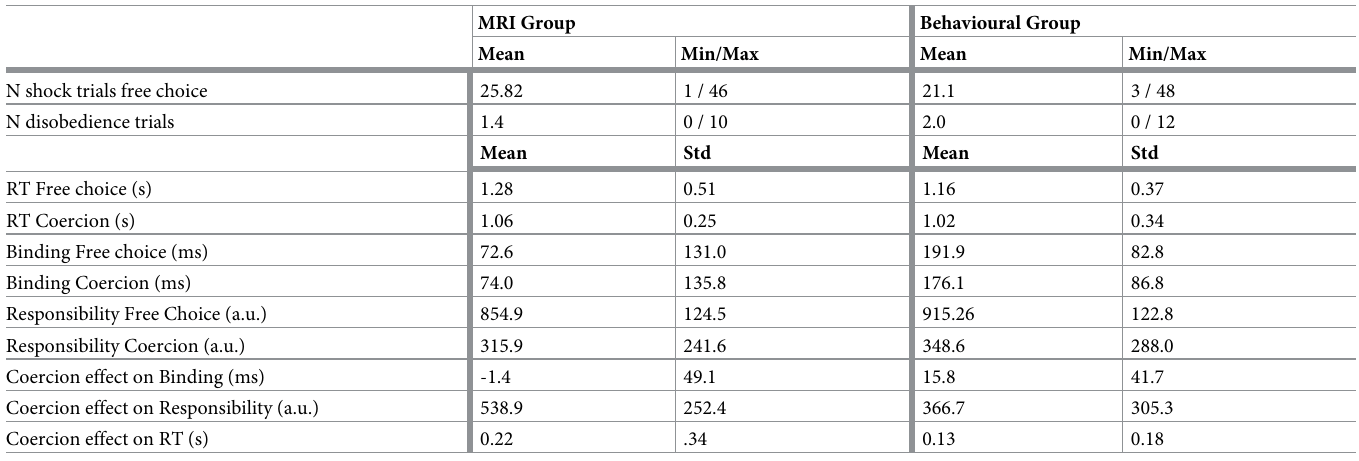
Table 1. Summary of behavioural